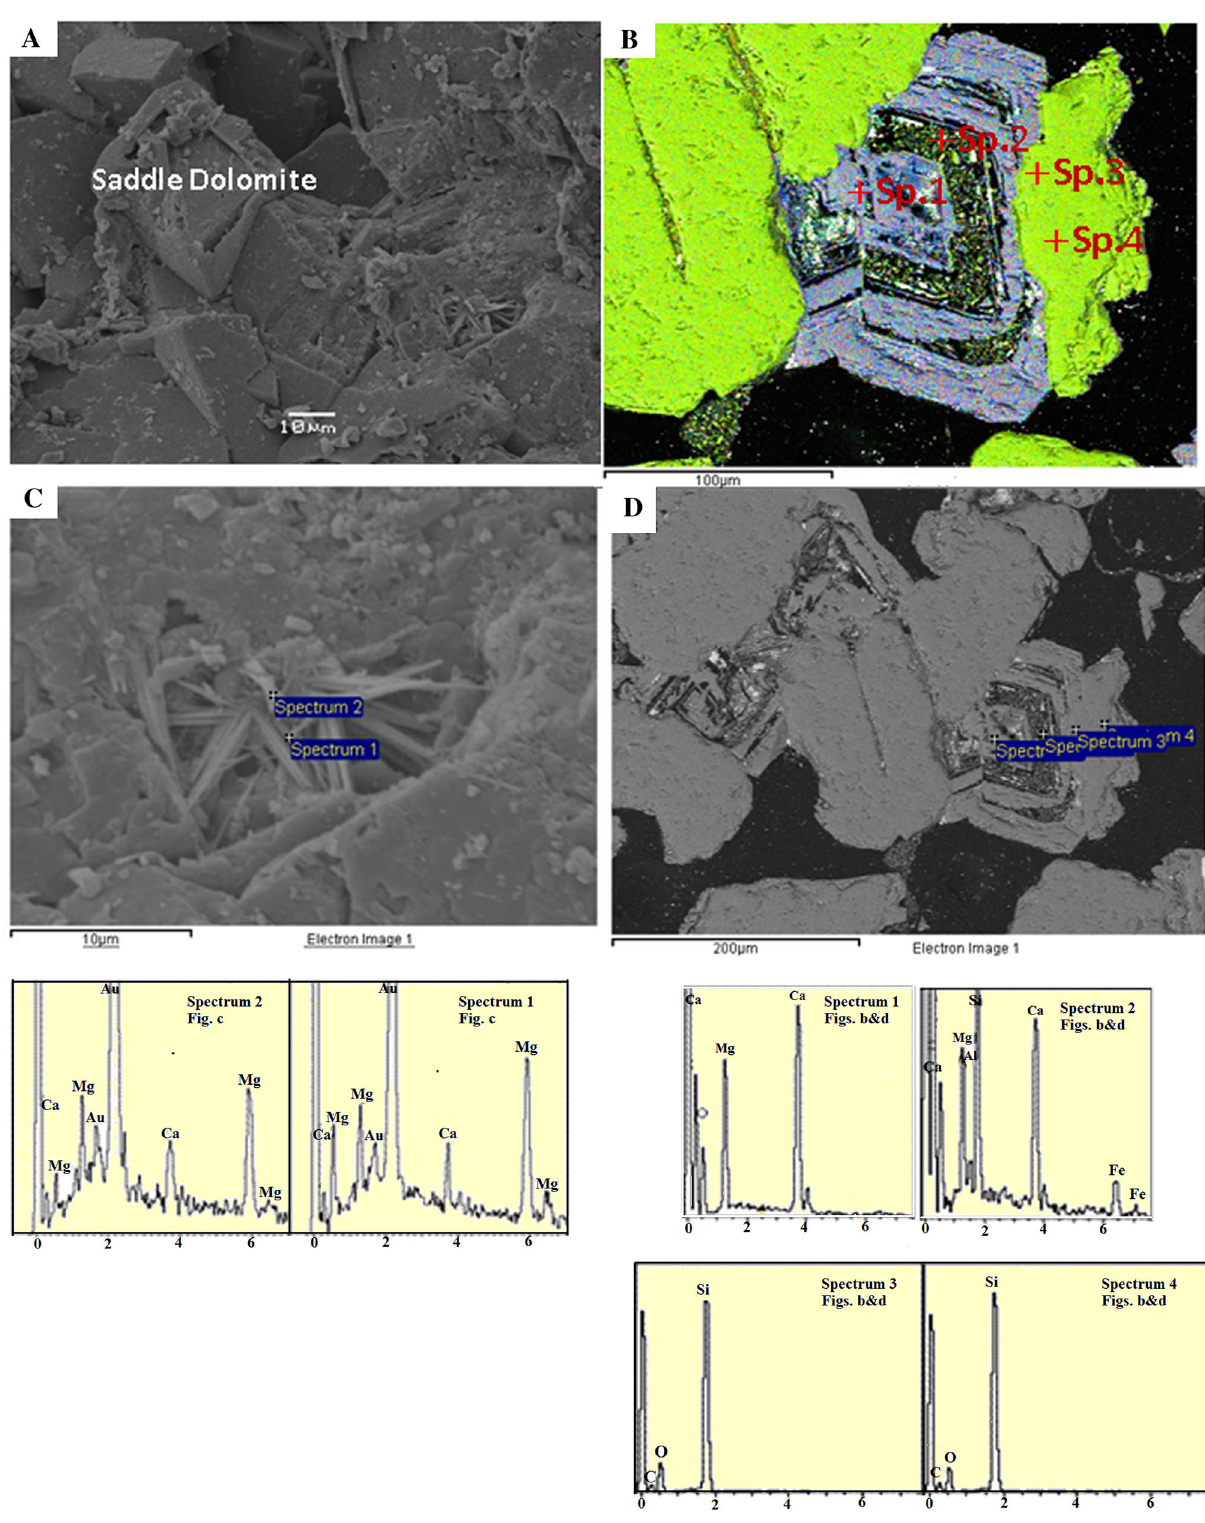
Fig. 11 SEM-BSE photomicrograph shows saddle dolomite crystals with inner core and multi